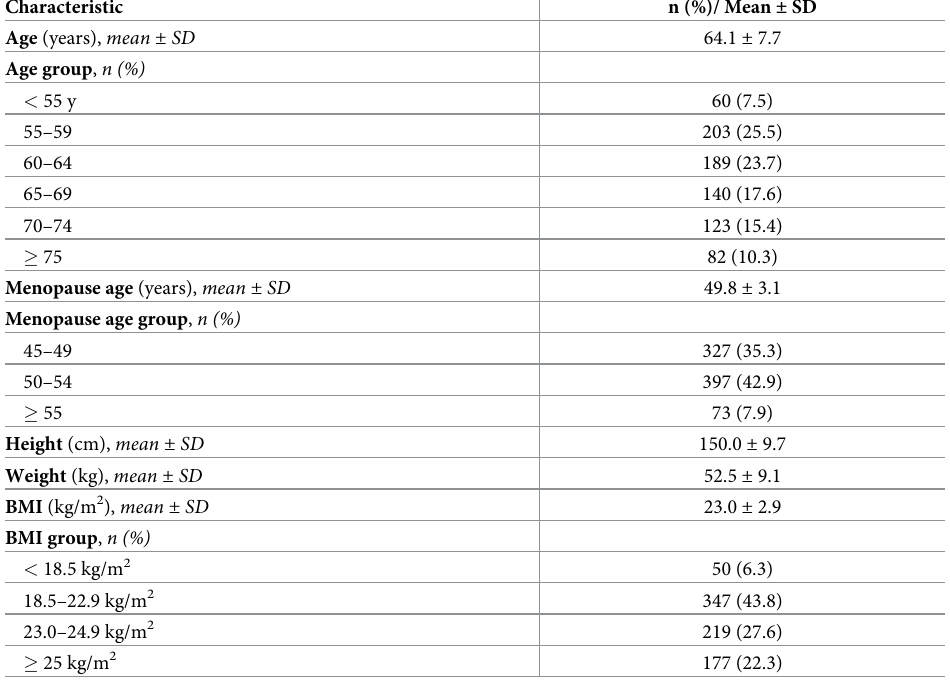
Table 1. Demographic characteristics (N =